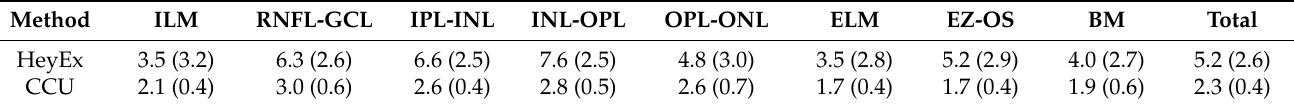
Table 5. A comparison between HeyEx segmentation and the proposed method (CCU-INSEG) using MAE (standard deviation) in µ m. Abbreviations: HeyEx—Heidelberg eye explorer (device integrated segmentation